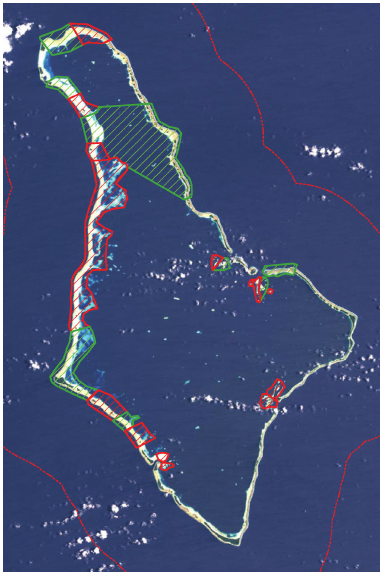
Figure 2: Example of mapping of existing conservation areas on JaluitAtoll. Type I areas (managed subsistence use only)are mapped in green and Type II areas (high level of protection) are mapped in